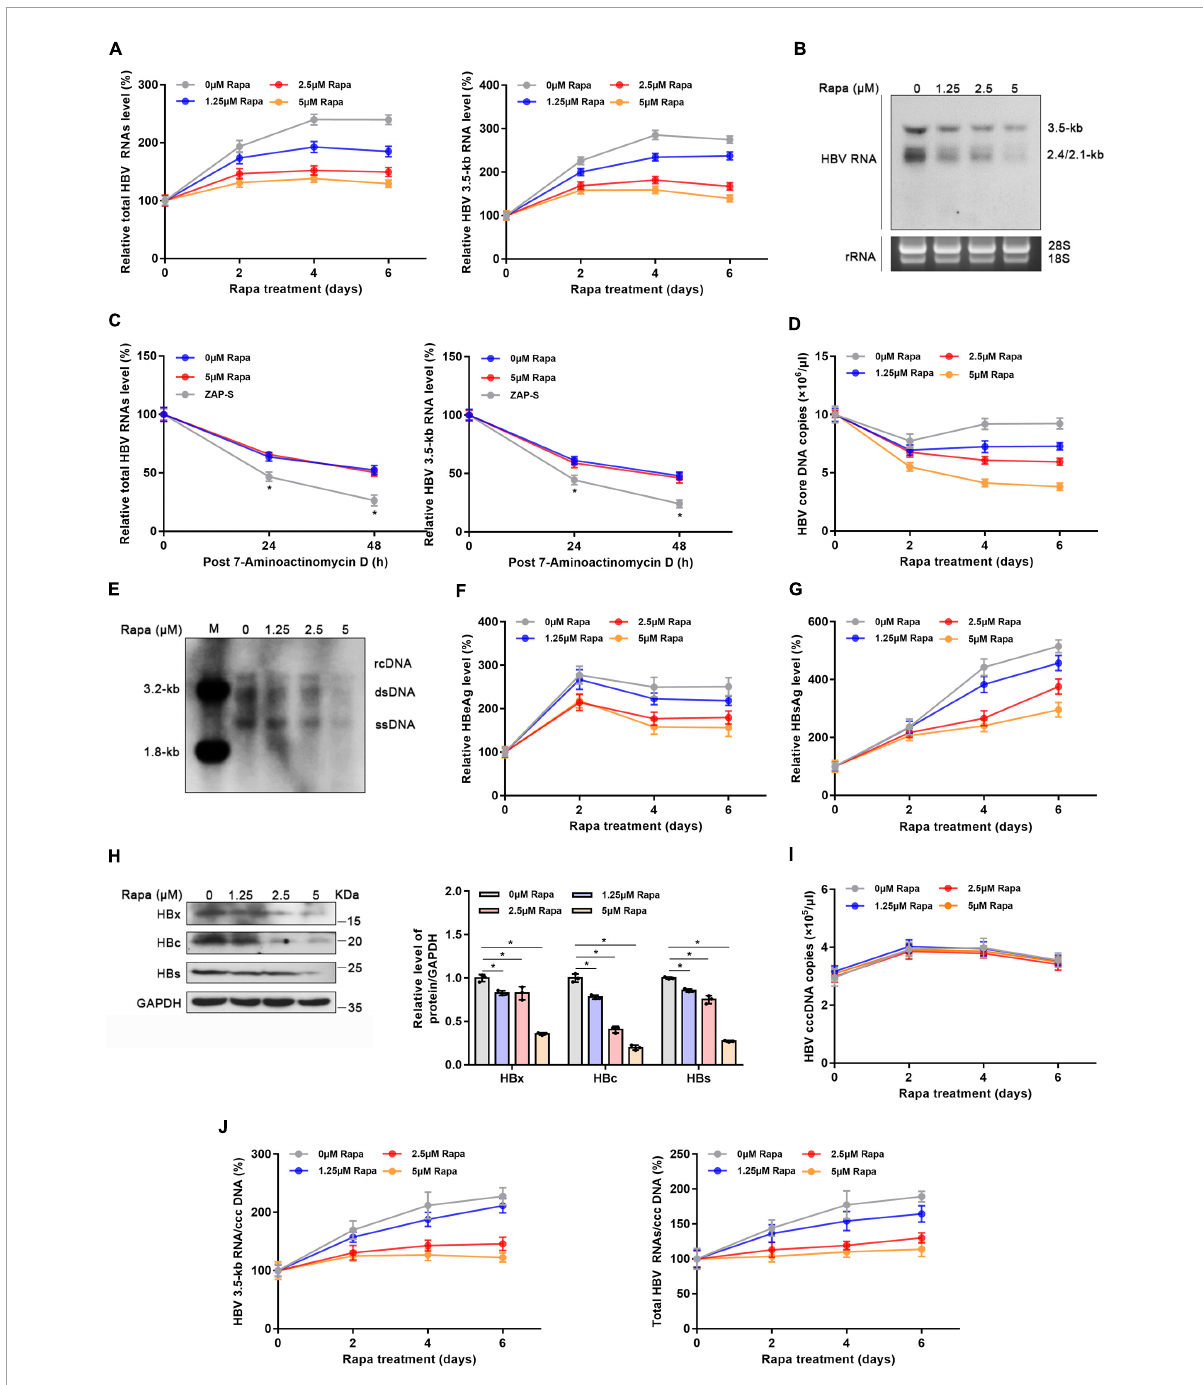
FIGURE3 Rapamycin blocked cccDNA transcription in HBV-infected HepG2-NTCP cells. HepG2-NTCP cells were infected with 10 3 genome equivalents/cells of HBV particles in the presence of 4% PEG8000 for 24 h. Two days after infection, the cells were treated with the appropriate concentration of rapamycin for 6 days. (A) The levels of total HBV RNAs and 3.5-kb RNA were detected by real-time PCR using specific primers. The β -actin mRNA level was used as an internal control. (B) Northern blotting hybridization of HBV RNAs by using a DIG-labeled HBV riboprobe. Ribosomal RNAs (28 and 18 s) served as the loading control. (C) HBV-infected cells were treated with 7-aminoactinomycin D (5 µ g/ml) for 24 or 48 h. HBV RNAs were quantified by real-time PCR. ZAP-S was used as a positive control. (D,E) The level of HBV core DNA was analyzed by real-time PCR analysis and Southern blotting analysis. (F,G) The levels of secreted HBsAg and HBeAg in the cell culture supernatant were detected by ELISA. (H) The levels of HBx, HBc, and HBs proteins were detected by western blotting analysis, and GAPDH was used as the loading control. (I,J) Total HBV RNA, 3.5-kb RNA, and cccDNA levels were analyzed by real-time PCR and were then used to calculate the ratio of total RNA/cccDNA or 3.5-kb RNA/cccDNA. The data are presented as the mean ± SD of three independent experiments. * P <